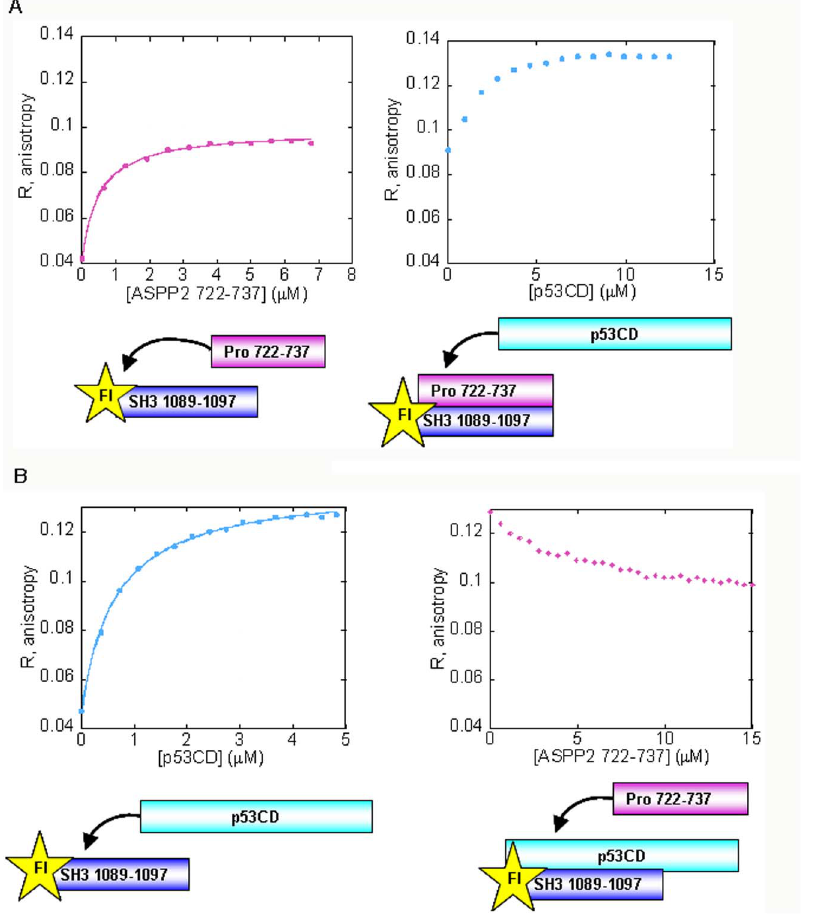
Figure 2. p53CD and ASPP2 Pro 723–737 compete for binding the Fl-ASPP2 n-src loop peptide residues 1089–1097: fluorescence anisotropy experiments. (A) A peptide derived from the proline rich domain of ASPP2 residues 722–737 binds the ASPP2 n-src peptide with K d =0.50 6 0.03 m M (magenta); Following titration of p53CD (cyan) into to the fully formed complex between Fl-ASPP2 1089–1097 and ASPP2 722– 737, the anisotropy increased (B) p53CD residues 94–312 bind the ASPP2 n-src peptide with K d =0.63 6 0.02 m M (cyan). Unlabeled ASPP2 722–737 (magenta) displaced p53CD form its fully formed complex with ASPP2 1089–1097.